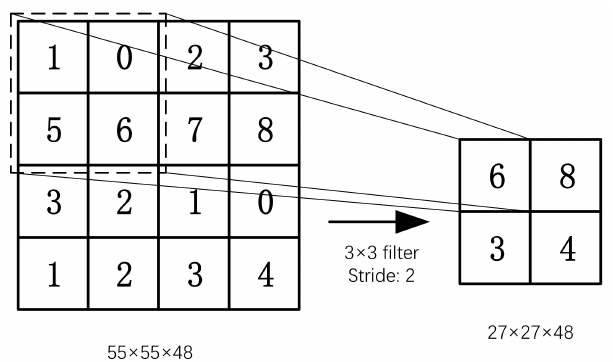
Figure 6. The process of